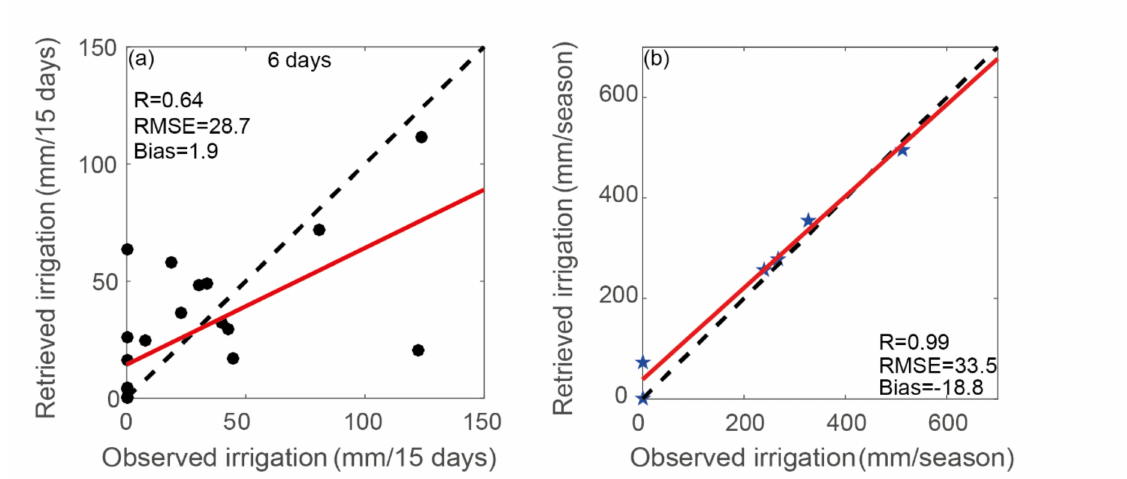
Figure 7. ( a ) Retrieved irrigation versus observed irrigation accumulated by 15 days, over the drip-irrigated field D1 during both seasons 2016–2017 and 2017–2018 for a 6-day window when assimilating Sentinel-1 SSM products; ( b ) Retrieved seasonal sum of irrigation versus observed seasonal sum of all the studied fields in this section (D1 and R1 both seasons, F2 and